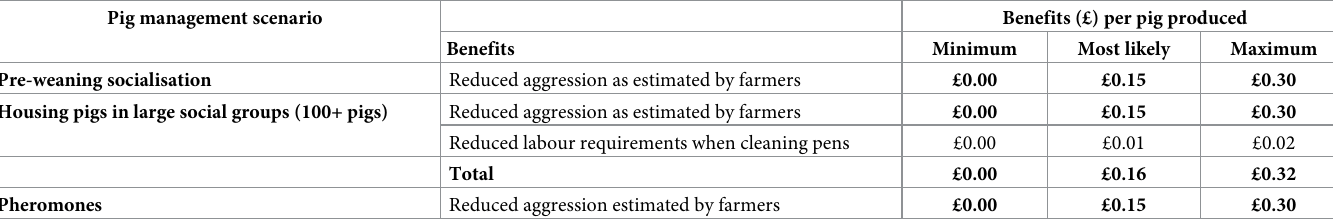
Table 7. The monetary benefits of each pig management scenario as included in the stochastic partial budgeting. Pig management